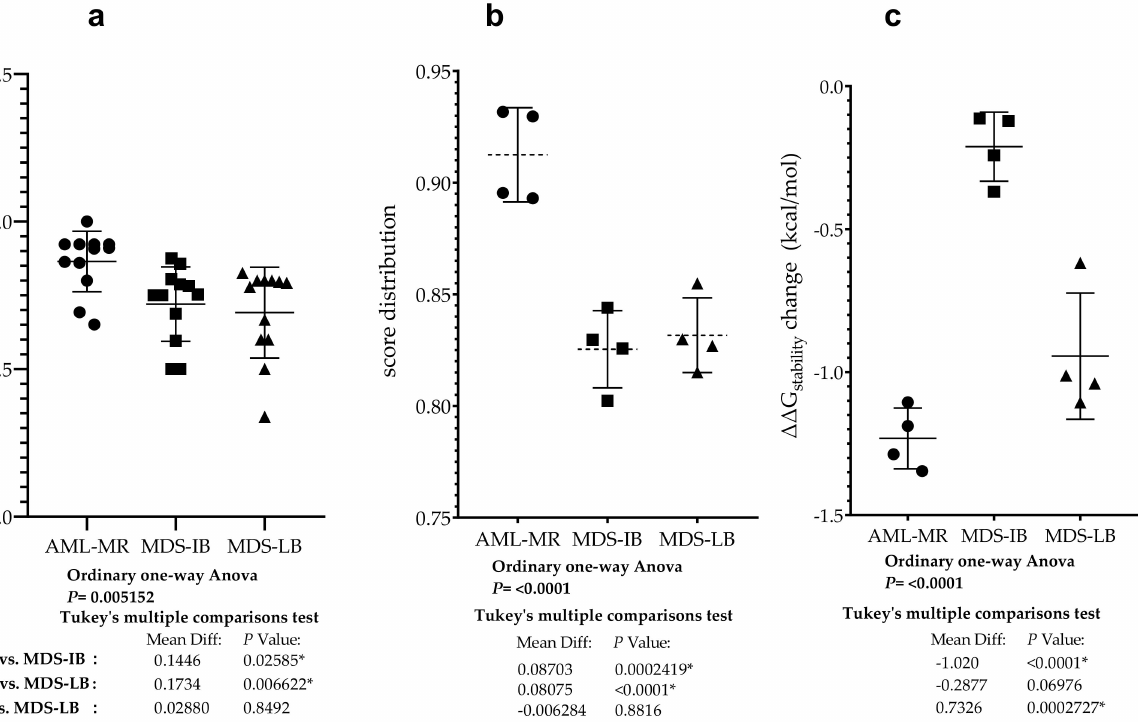
Figure 10. Differences between AML/MDS patients in the sight of mutant p53 protein pathogenicity and structural stability. ( a ): Comparison of the severity of p53 mutations found in AML-MR, MDS-IB, and MDS-LB cases. Significant differences were found between two of the three members based and scores in Figure 5c,d. ( b ): Comparison of p53 mutations’ pathogenicity in the three groups using REVEl, BayesDel, Varity, and FATHMM-XF scores (Figure 5d). ( c ): Statistical differences between the three patients’ groups according to the changes in p53 protein stability predicted by their mutations with methods from Figure 5b. * indicate the statistically significant differences, p values are described in the